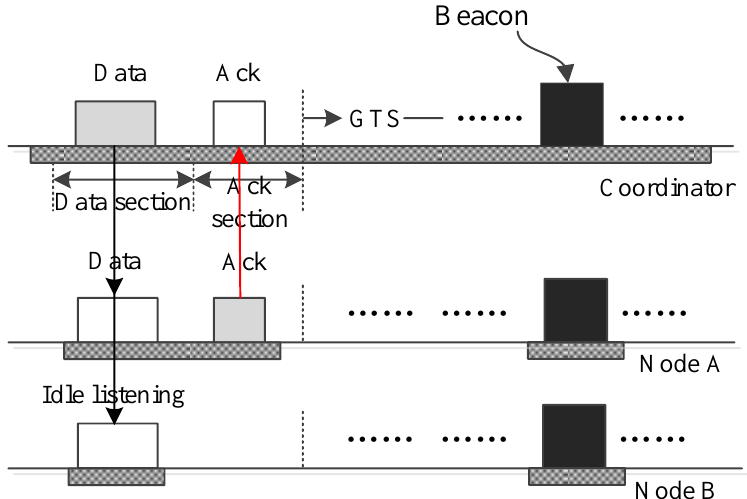
Figure 4. The coordinator sends small data to one node. GTS, guaranteed time slot.